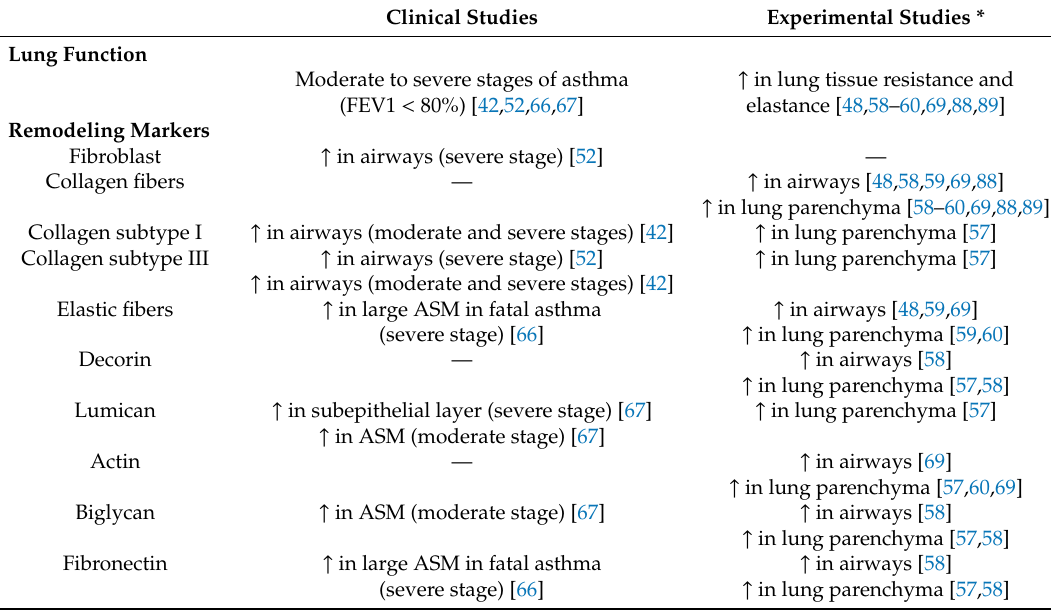
Table 1. Lung function changes and markers of airway remodeling in asthma. Clinical Studies Experimental Studies